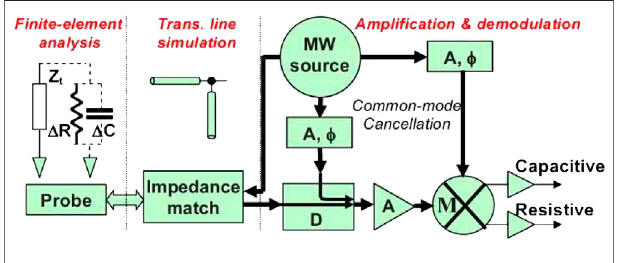
FIGURE 1 | Schematic diagram of MIM. Reproduced with permission from Rev. Sci. Instrum. 79, 6 (2008). Copyright 2008 American Institute of Physics.